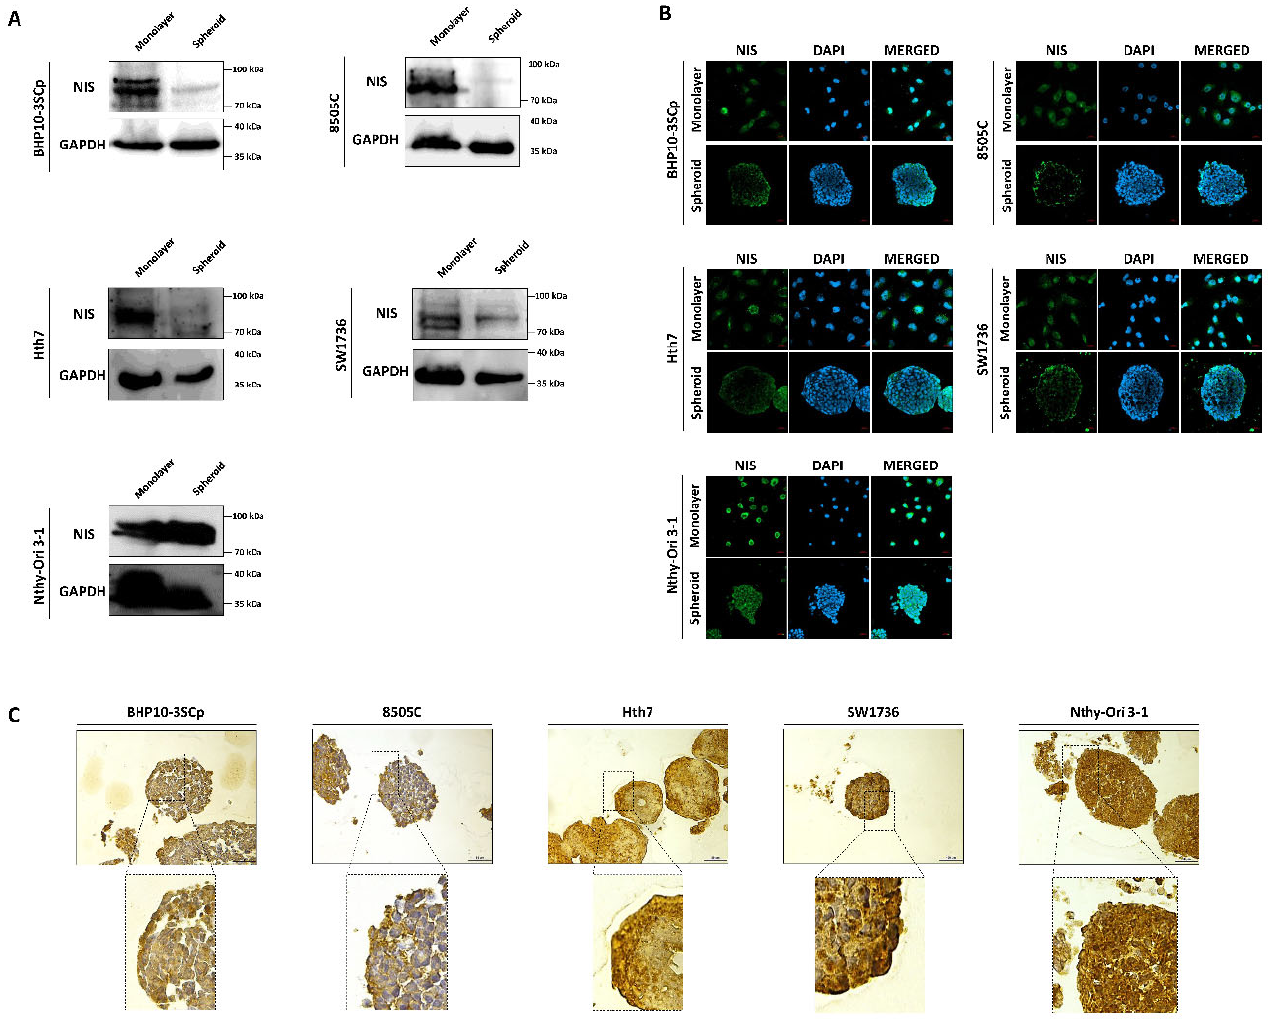
Figure 7. Evaluation of change with sodium iodide symporter (NIS) under 2D monolayer condition and 3D spheroid condition. ( A ) Western blot analysis showed NIS expression. GAPDH was used as a loading control. ( B ) Representative immunofluorescence images showing NIS. Scale bar: 50 µ m. ( C ) Representative immunohistochemical images for NIS with spheroids. Scale bar: 50 µ m.